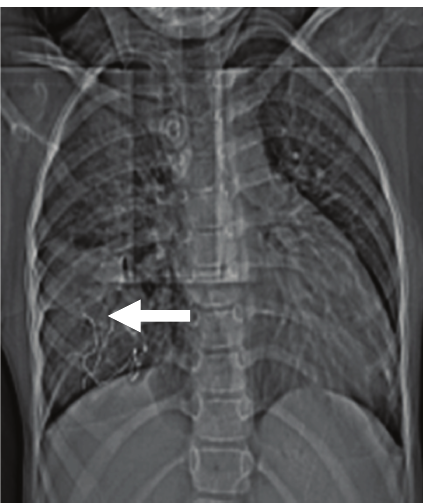
Figure 1: CT scanogram, showing a rounded inhomogeneous radio-opacity in the right lower hemithorax.The center of the lesion is having thin, comparatively dense lines, representing the radio- opaque markers in the retained surgical sponge (Arrow). Figure 2: Un-enhanced CT scan section of the thorax, in bone